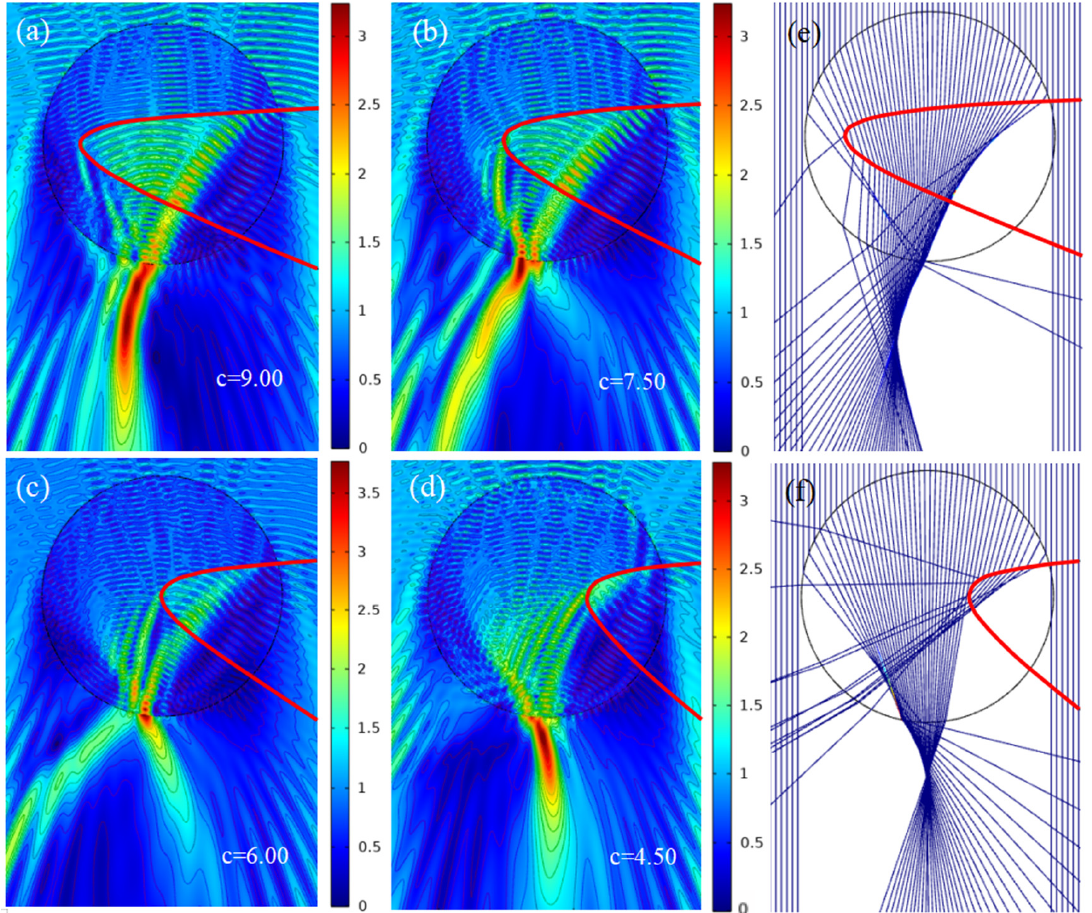
Figure 5. Distribution of electric field and ray optics under plane wave illumination. ( a ) P ( − 9.00,0). ( b ) P ( − 7.50,0). ( c ) P ( − 6.00,0). ( d ) P ( − 4.50,0). ( e ) Ray optical model with P ( − 9.00,0). ( f ) Ray optical model with P ( − 4.50,0). ( a – f ) Fixed upper intersection M (0,1.31) and fixed lower intersection N (0, − 4.47).